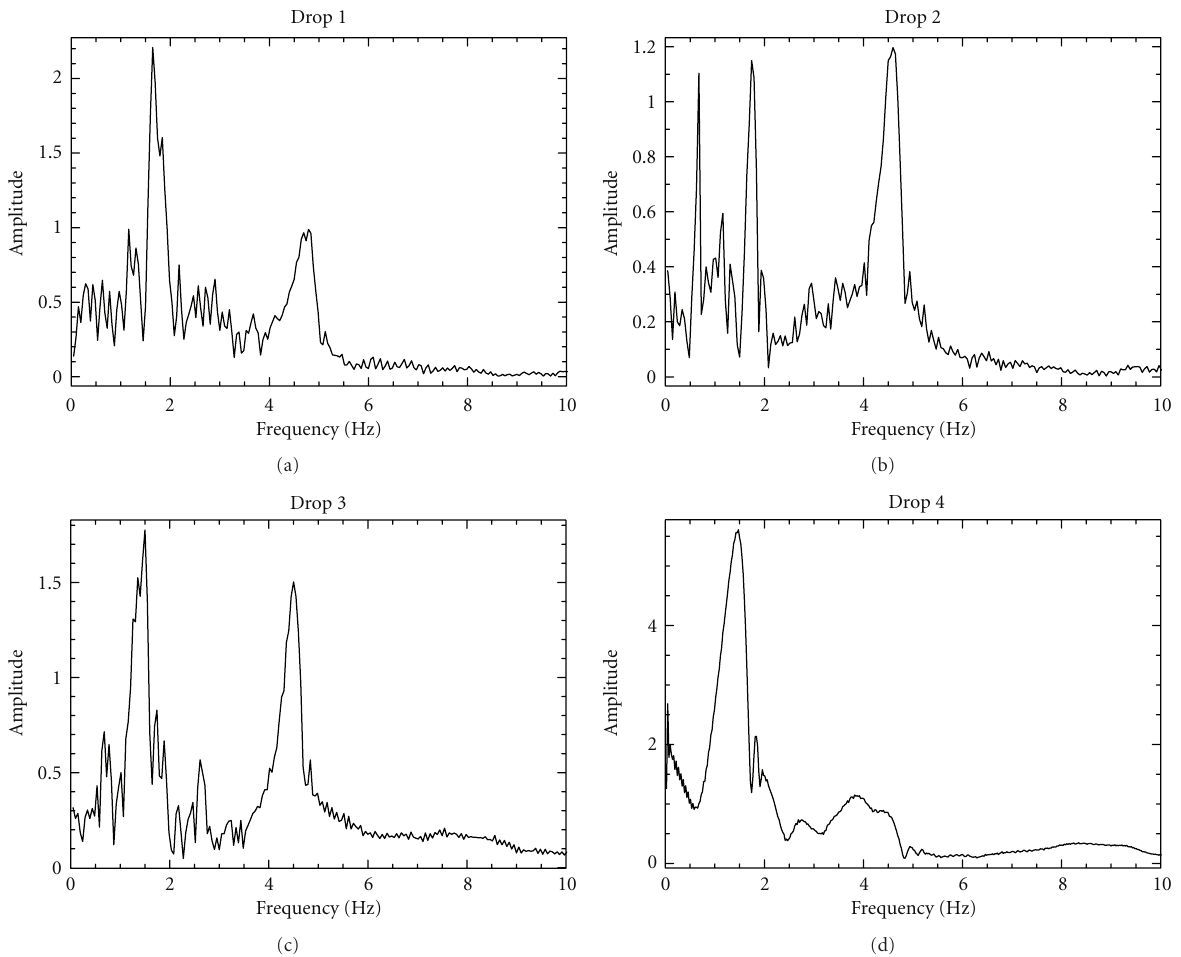
Figure 6: The graphs report the frequency domain response of the beam during the four drops, a frequency range up to 10 Hz is considered.